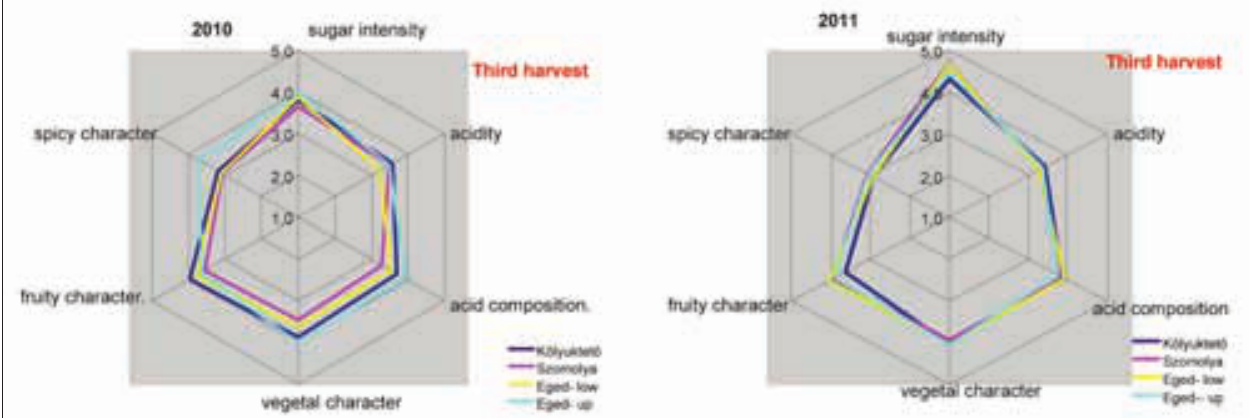
Figure 2c: Main sensorial characters of the pulp (2010-2011- Third harvest time)